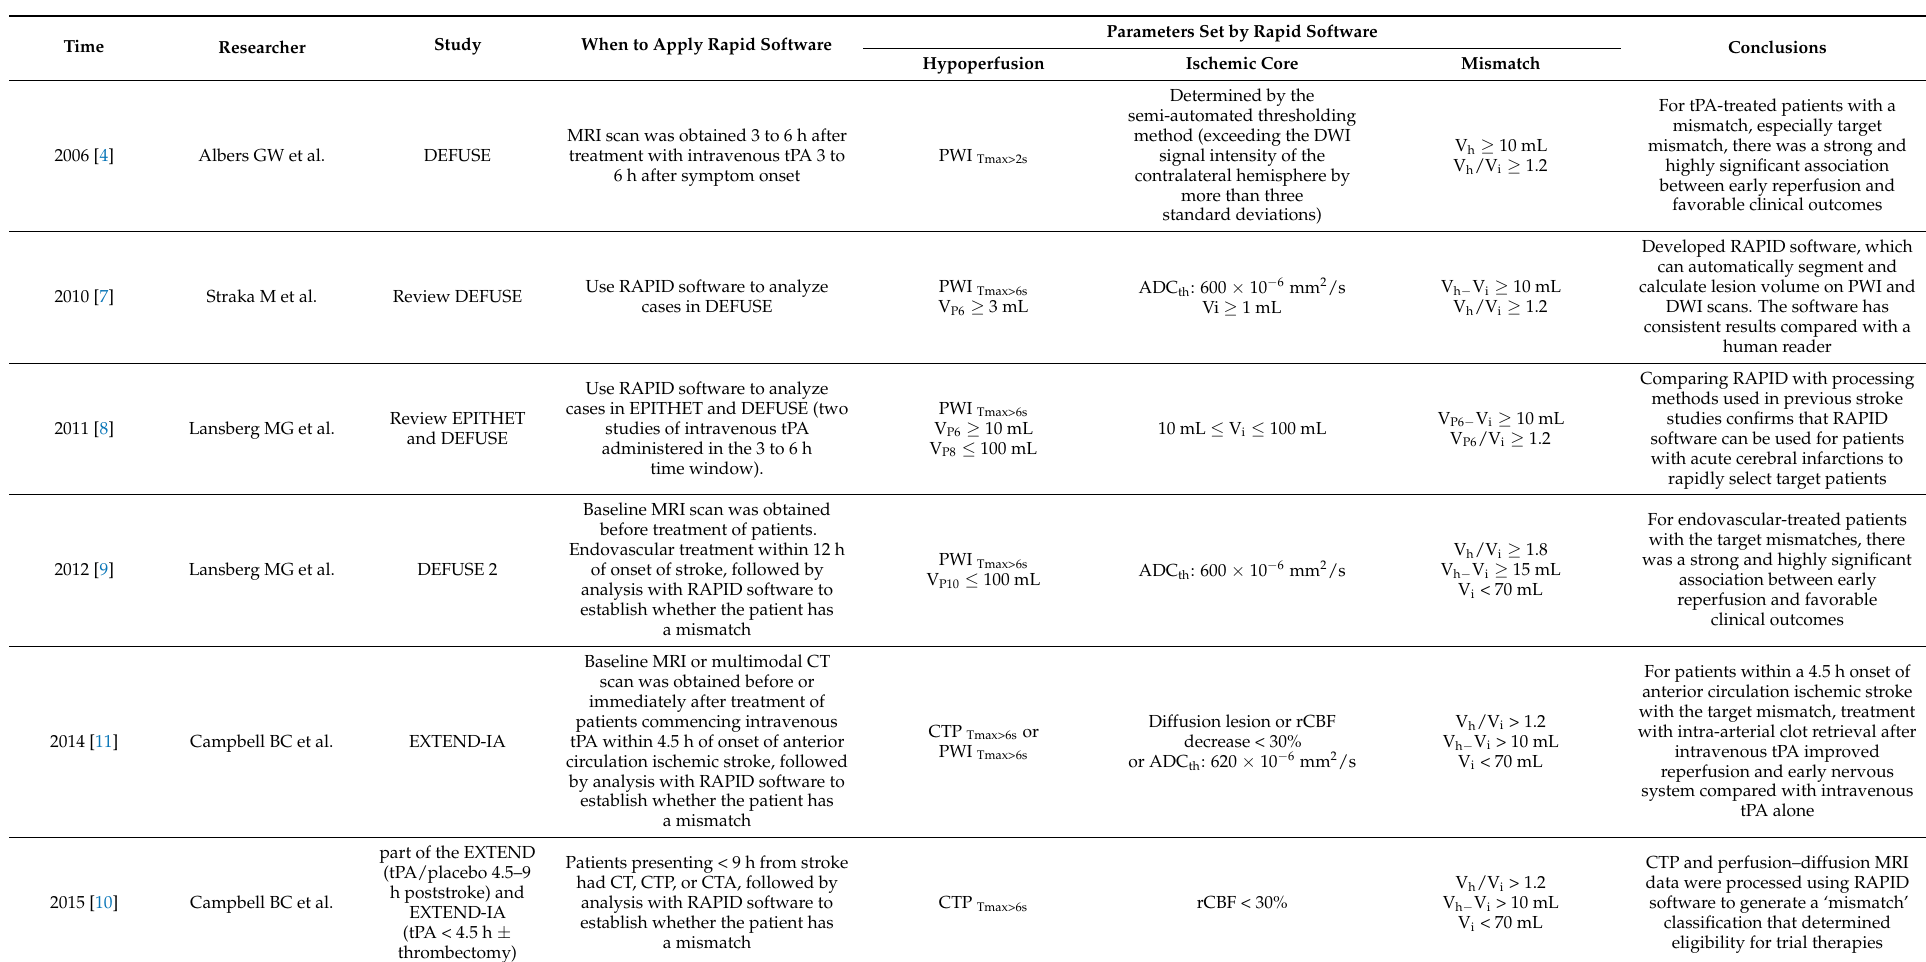
Table 1. Application of RAPID software in various clinical